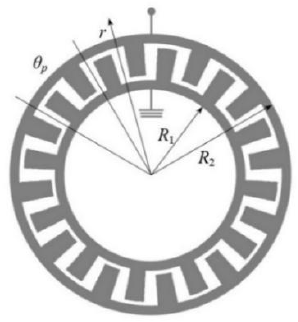
Figure 2. Inter-digital transducer.